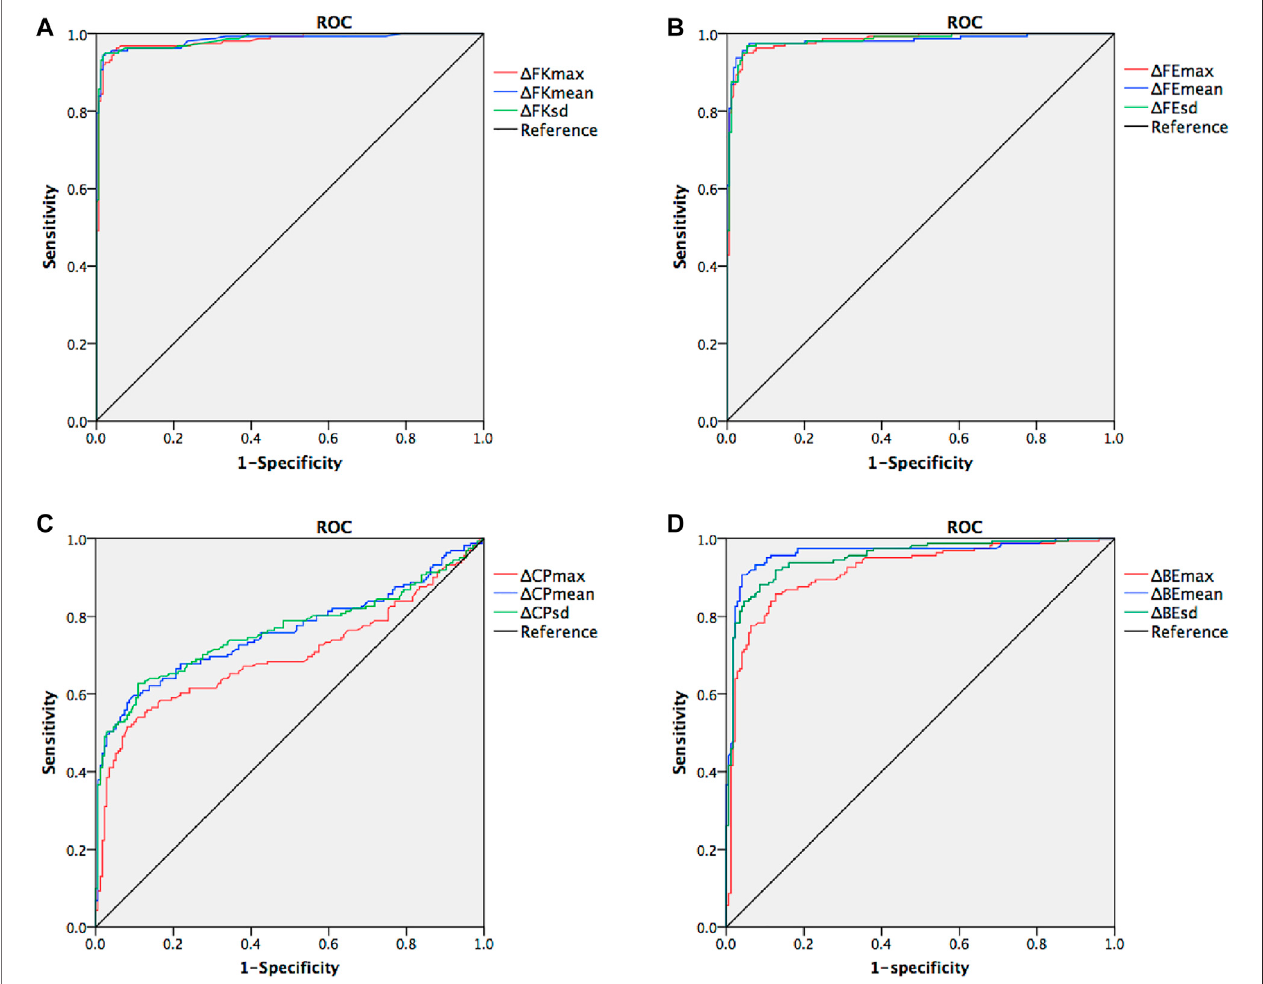
FIGURE 5 | Receiver operating characteristic curves (ROC) for keratoconus versus normal cases. (A) combined ROC for Δ FKmax, Δ FKmean, and Δ FKsd (B) combined ROC for Δ FEmax, Δ FEmean, and Δ FEsd (C) combined ROC for Δ CPmax, Δ CPmean, and Δ CPsd (D) combined ROC for Δ BEmax, Δ BEmean, and Δ BEsd.